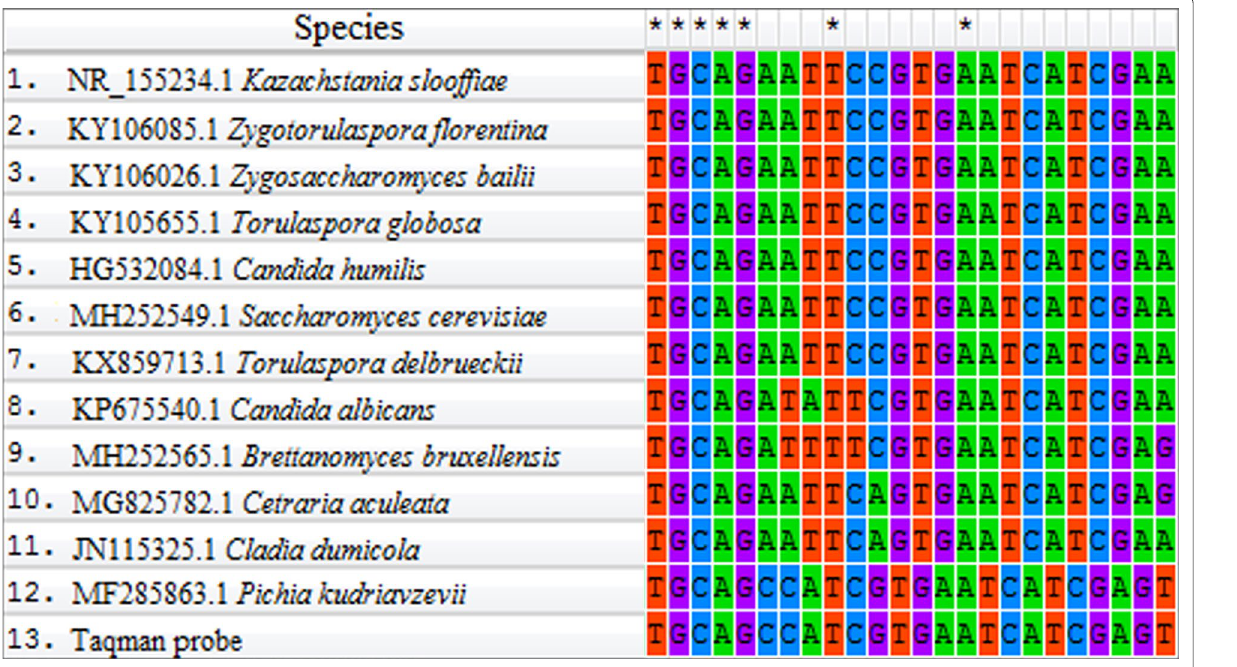
Fig. 3. The linear dependence of the Cq parameter on the concentration of the genomic DNA of P. kudriavzevii was observed (Fig. 4), which means that the reaction is specific only to the target DNA without the formation of non-specific products. The minimum amount of Pichia sp. DNA that could be detected by our method was 50 fg. To estimate the detection, total DNA was isolated from 10, 50, 100, 1000, and 10,000 cells of P. kudriavzevii and used as a tem- plate in the same PCR. The minimal number of yeast that could be detected by our method without pre-enrich- ment was 50 cells.